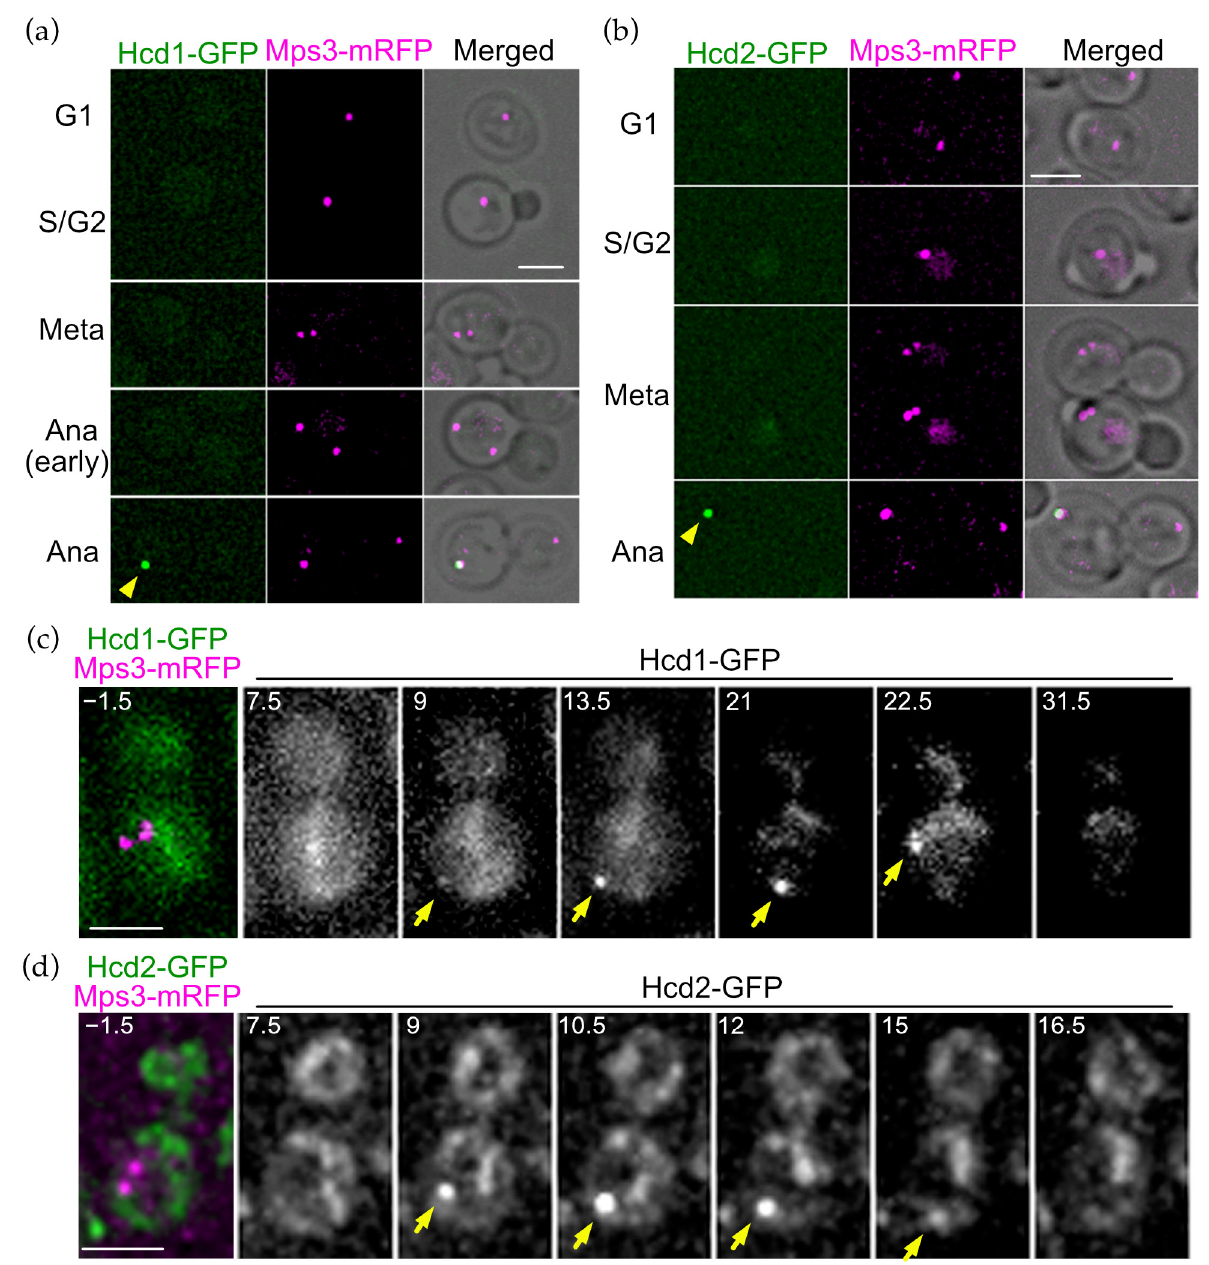
Figure 4. OpHcd1 and OpHcd2 localise to the SPB in the mother cell body during anaphase. ( a ) Cell cycle dependent localisation of OpHcd1-GFP. OpHCD1-GFP MPS3-mRFP cells (HPH1605) were grown in YPDS medium at 30 ◦ C. Mps3-mRFP is an SPB marker. Shown are deconvolved and projected GFP and RFP images and merged brightfield, GFP, and RFP images. Yellow arrowhead indicates Hcd1-GFP signal. Meta: metaphase. Ana: anaphase. Scale bar, 2 µ m. ( b ) Cell cycle dependent localisation of OpHcd2-GFP. OpHCD2-GFP MPS3-mRFP cells (HPH1608) were grown in YPDS medium at 30 ◦ C. Mps3-mRFP is an SPB marker. Shown are deconvolved and projected GFP and RFP images and merged brightfield, GFP, and RFP images. Yellow arrowhead indicates Hcd2-GFP signal. Meta: metaphase. Ana: anaphase. Scale bar, 2 µ m. ( c ) Time-lapse microscopy of OpHCD1-GFP MPS3-mRFP cells (HPH1605). Images were taken every 90 sec. RFP image was only captured before the start of the time-lapse series. The cell entered into anaphase before the 9 min timepoint judged by the position of the Hcd1-GFP dot. The Hcd1-GFP signal returned to the cell centre at the 22.5 timepoint, suggesting that mitotic exit occurred between the 21 min and the 22.5